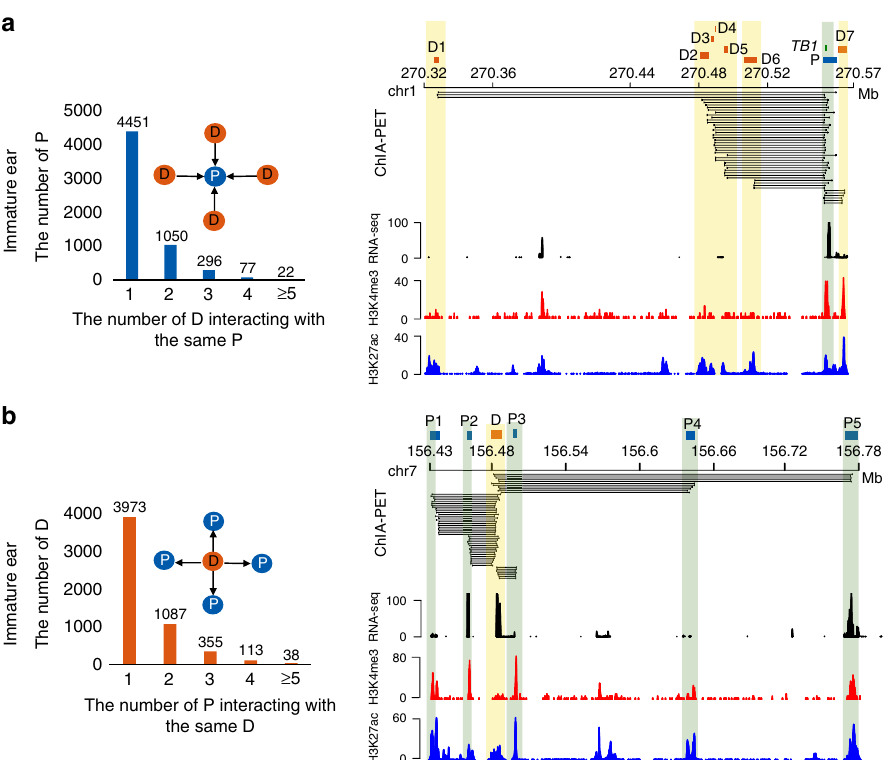
Fig. 4 Chromatin interaction mode in immature ear. a The left panel is the summary bar chart showed the number of proximal paired-end tag (PET) peaks (P) ( x axis) interacting with various numbers of distal PET peaks (D) ( y axis) in immature ear. The corresponding right panel is an example of one promoter ( TB1 ) interacting with seven D in immature ear. b The left panel is the summary bar chart showed the number of D ( x axis) interacting with various number of P ( y axis) in immature ear. The corresponding right panel is an example of one D interacted with fi ve P in immature ear. The green rectangle represents the corresponding gene. The blue and orange rectangles indicate P and D, respectively. P was highlighted in dark green, and D was highlighted in yellow. Source Data of Fig. 4a, b are provided as a Source Data fi